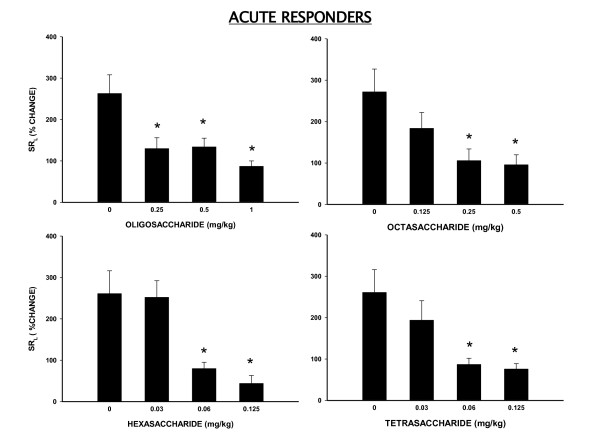
Effect of inhaled heparin-oligosaccharides on antigen-induced bronchoconstrictor response in "Acute Responder" sheep. Data are shown as % change in specific lung resistance (SRL) ± SE without and after pretreatment with different dose of oligosaccharide mixture (n = 6) and various fractions including octasaccharide (n = 5), hexasaccharide (n = 5) and tetrasaccharide(n = 5). *Significantly different from antigen control (P < .05).